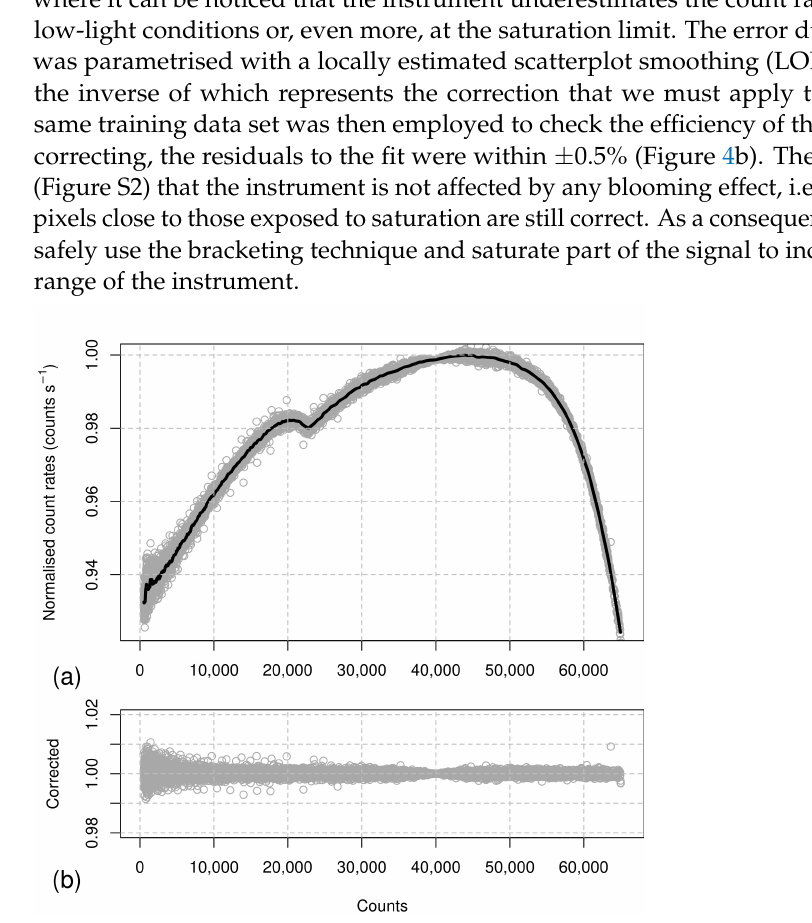
Figure 4. Effect of non-linearity in the AvaSpec. ( a ) Ratio between count rates (as a function of the counts) and the same quantity measured at 40,000 counts. The results were further normalised to the maximum of the curve. The thick line is a locally estimated scatterplot smoothing (LOESS) interpolation through all points (grey). ( b ) Same as ( a ) after non-linearity